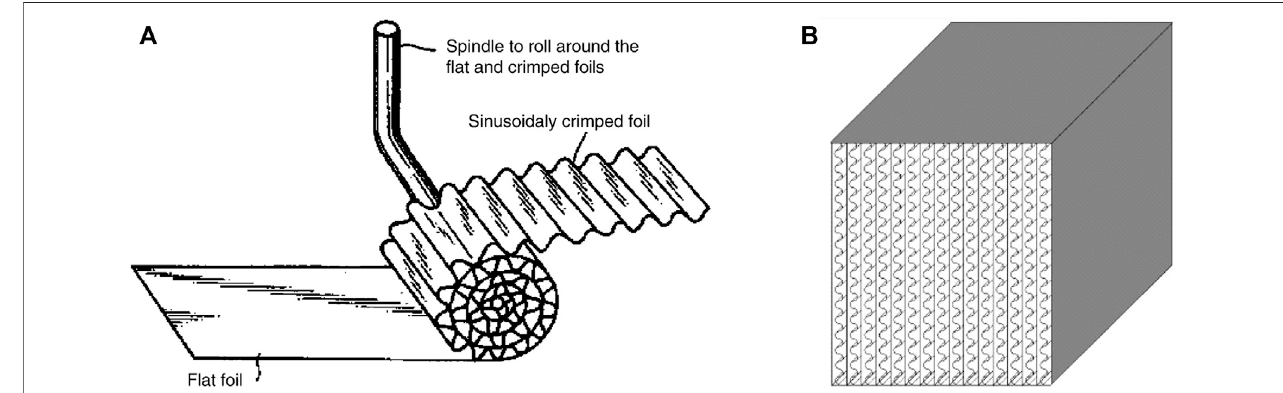
FIGURE 1 | Example of monolith construction by rolling around a spindle (A) and piling up alternates fl at and crimped foils (B) (adapted from (Avila et al., 2005)).